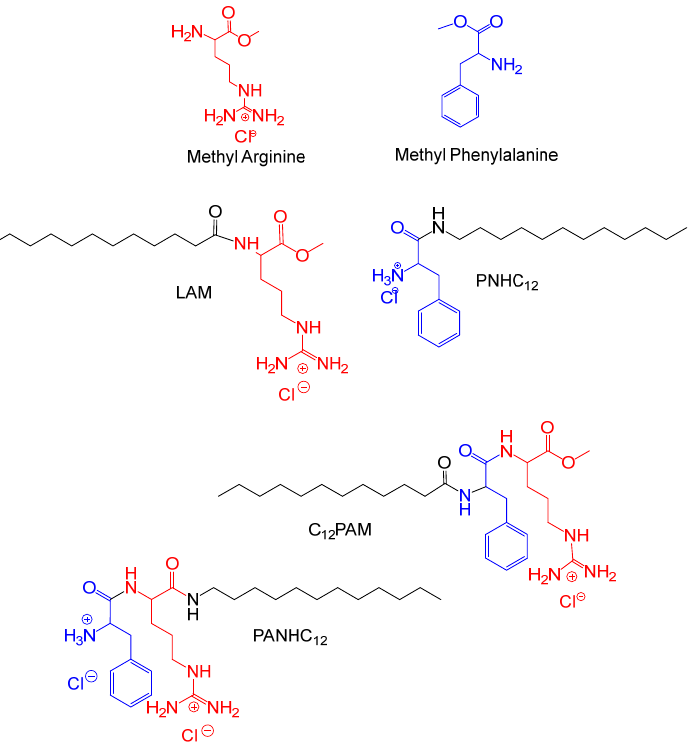
Figure 1. Molecular structures of amino acid-based surfactants. Lauroyl Arginine methyl ester (LAM), Phenylalanine lauroyl amide (PNHC 12 ), Lauroyl Phenylalanine Arginine methyl ester (C 12 PAM), Phenylalanine Arginine lauroyl amide (PANHC 12 ).